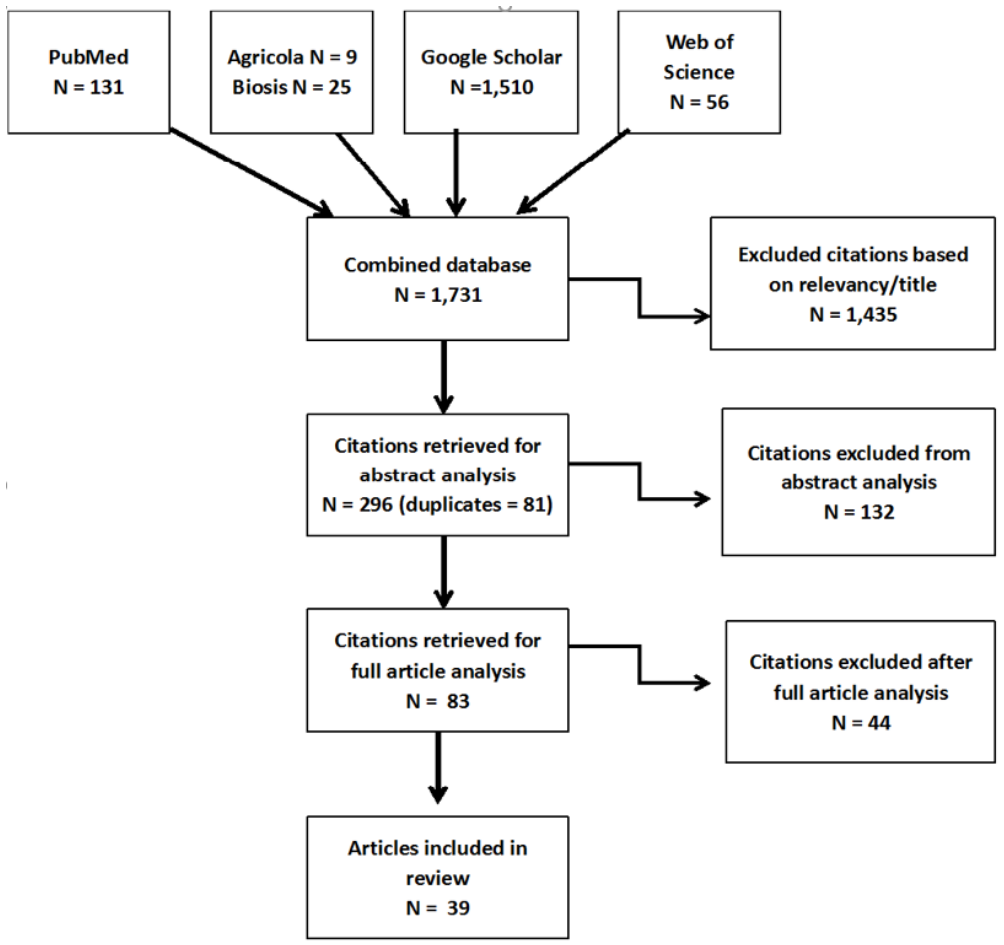
Figure 1. Flowchart of article selection.